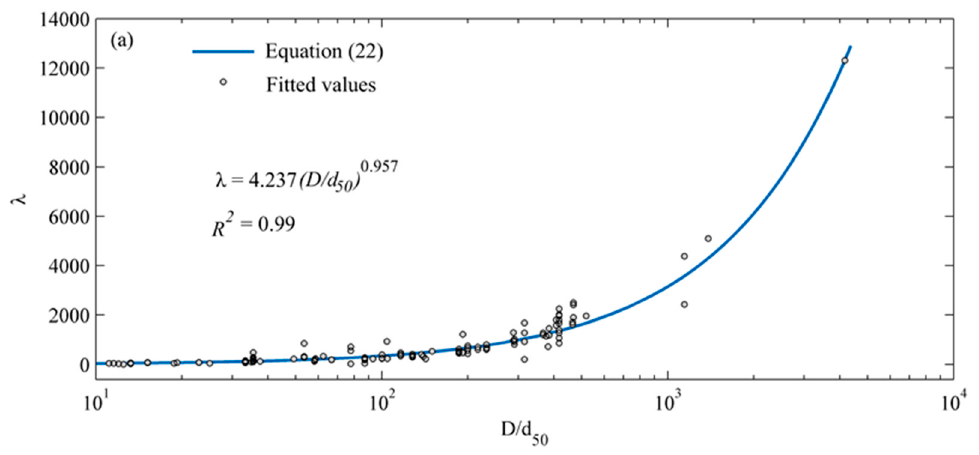
Figure 5. ( a ) (cid:2019) values in function of (cid:1830) (cid:1856) 50 ⁄ ; ( b ) Residual values for (cid:2019) in comparison with estimated values using Equation (18). 5.2.2. (cid:1852) (cid:3040)(cid:3028)(cid:3051)∗ , (cid:1849) (cid:3040)(cid:3028)(cid:3051)∗ , and (cid:1845) Estimation As mentioned in Section 4.2, the S/M formulation was taken into consideration and Equation (18) can be multiplied by 2(cid:1856) (cid:2873)(cid:2868) (cid:1830)⁄ in order to have (cid:1852) ∗ on the left side of the equation, (cid:1852) (cid:3040)(cid:3028)(cid:3051)∗ = (cid:1878) (cid:1830) (cid:3436)2(cid:1856) (cid:2873)(cid:2868) (cid:1830) (cid:3440) = 2.5(cid:1858) (cid:2869) (cid:1858) (cid:2870) (cid:1858) (cid:2871) (cid:3436)2(cid:1856) (cid:2873)(cid:2868) (cid:1830) (cid:3440) (23) The hydraulic effects in the original S/M formulation are represented by (cid:1858) (cid:2869) and (cid:1858) (cid:2870) . On the other hand, (cid:1849) ∗ has the capacity to integrate these hydraulic effects on the local scour process. Therefore, (cid:1858) (cid:2869) and (cid:1858) (cid:2870) can take a convenient value with the aim of writing it in a function of (cid:1849) (cid:3040)(cid:3028)(cid:3051)∗ . Considering (cid:1858) (cid:2869) = 1 = (cid:1858) (cid:2870) makes it possible to be on the safe side from a design perspective and, consequently, this value was selected: